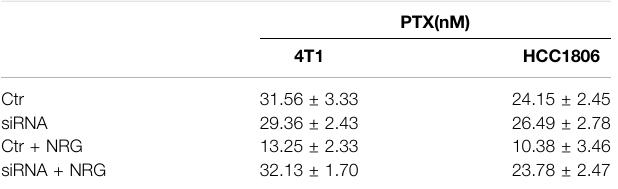
TABLE 3 | Half maximal inhibitory concentration (IC50) of groups cells treated with